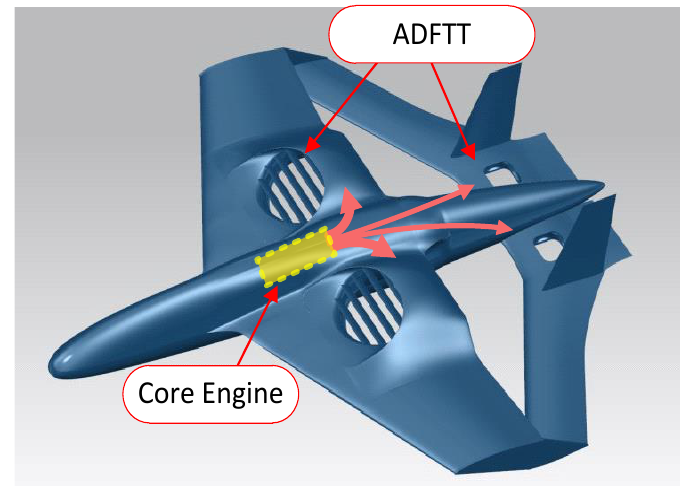
Figure 2. The conceptual UAV using an air-driven fan with a tip turbine.